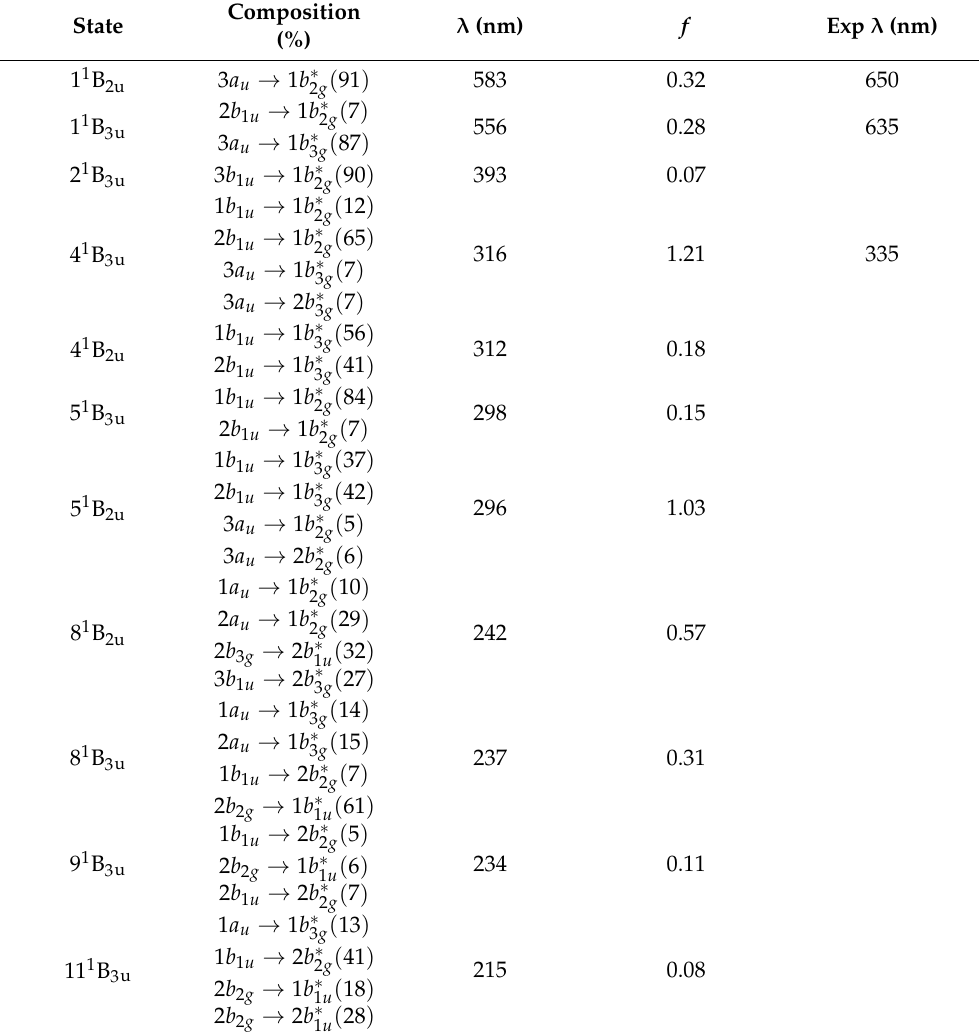
Table 4. Calculated composition of the lowest excited states and corresponding oscillator strengths for H 2 TTDPz molecule.